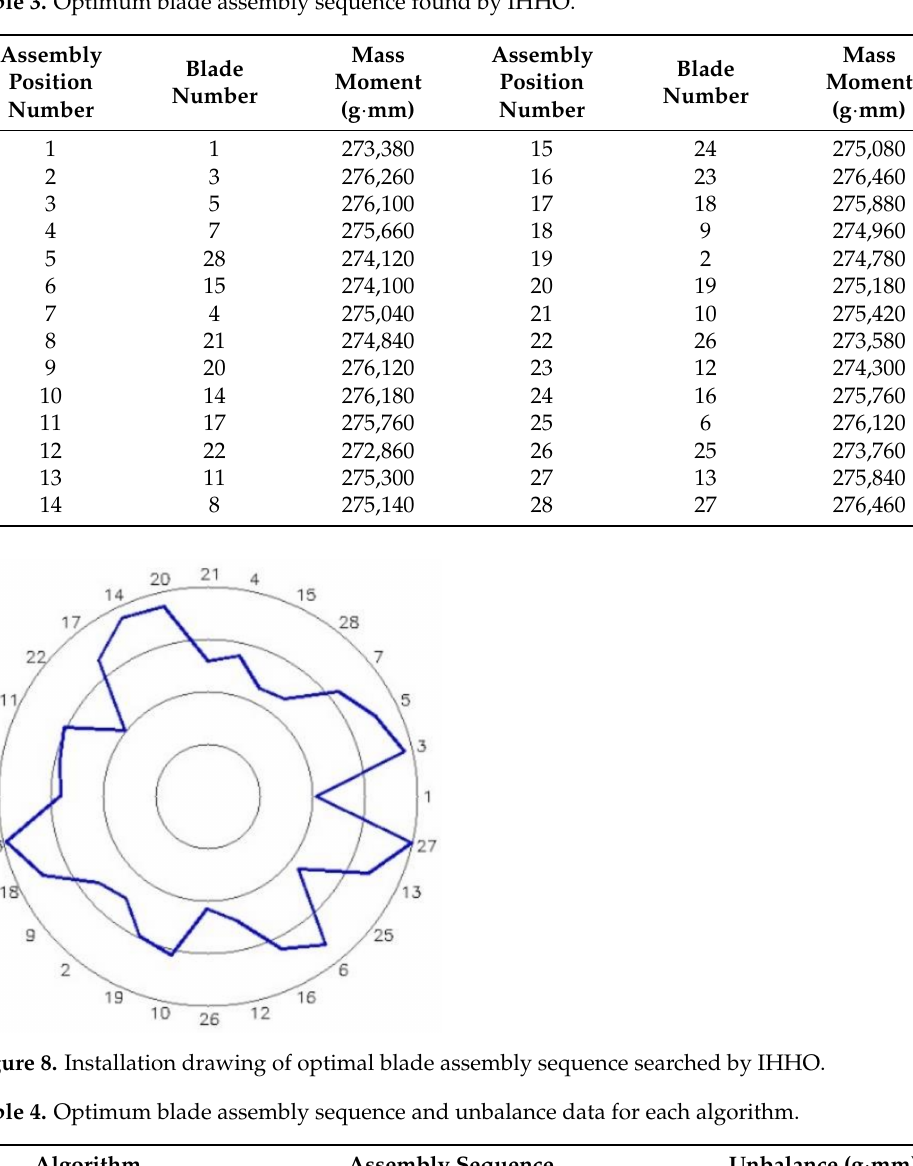
Table 3. Optimum blade assembly sequence found by IHHO.